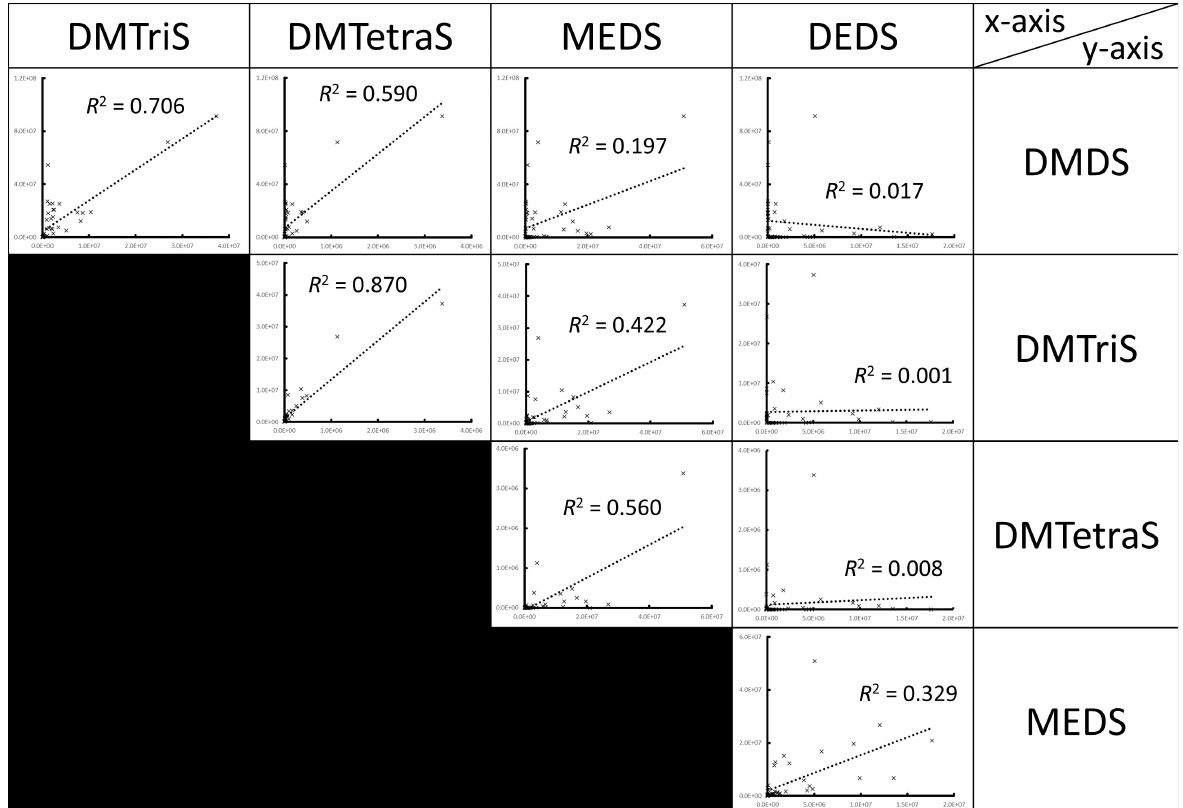
Figure 2. Plots of peak areas of each polysulfide and their respective coefficients of determination. The x -axis and y -axis in each plot are shown respectively in the top row and the right